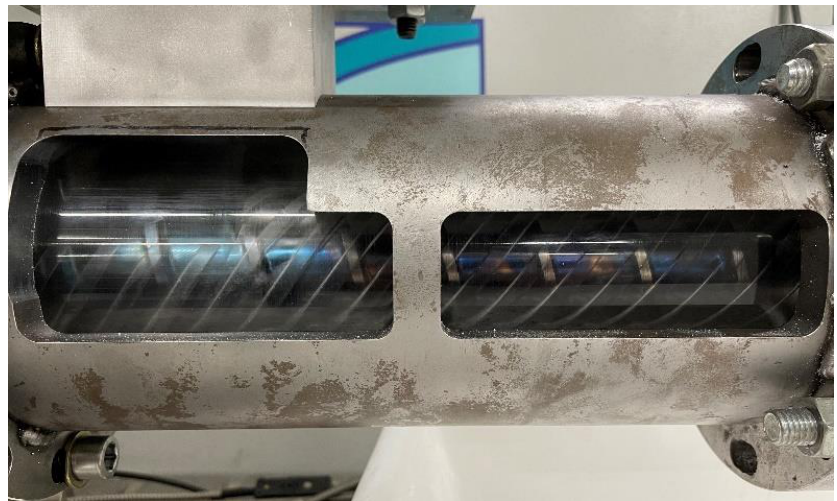
Figure 6. Experimental set-up using a helically grooved PMMA barrel.